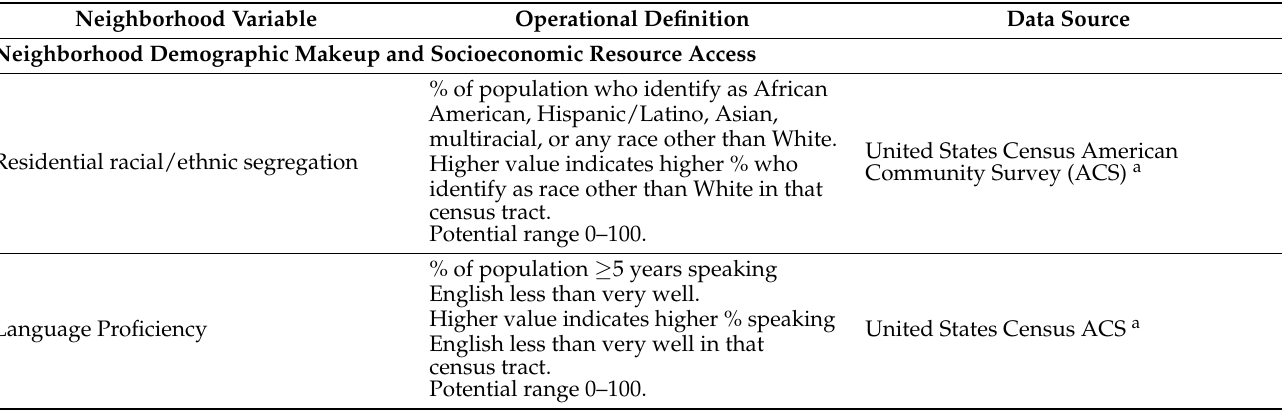
Table 1. Operationalization and data source for neighborhood variables included in neighborhood ACEs